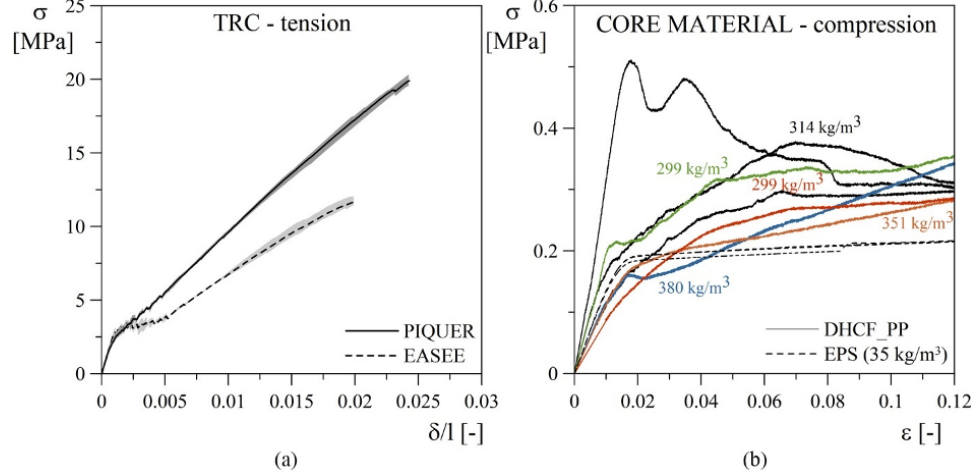
Figure 1. Test results: TRC tensile behaviour (a) and core material compressive behaviour